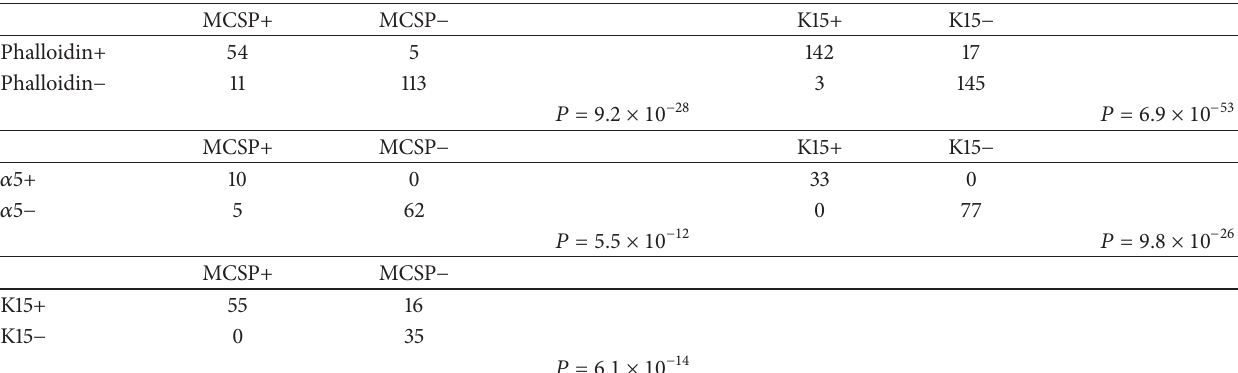
Table 1: Colocalization of APM and stem cell